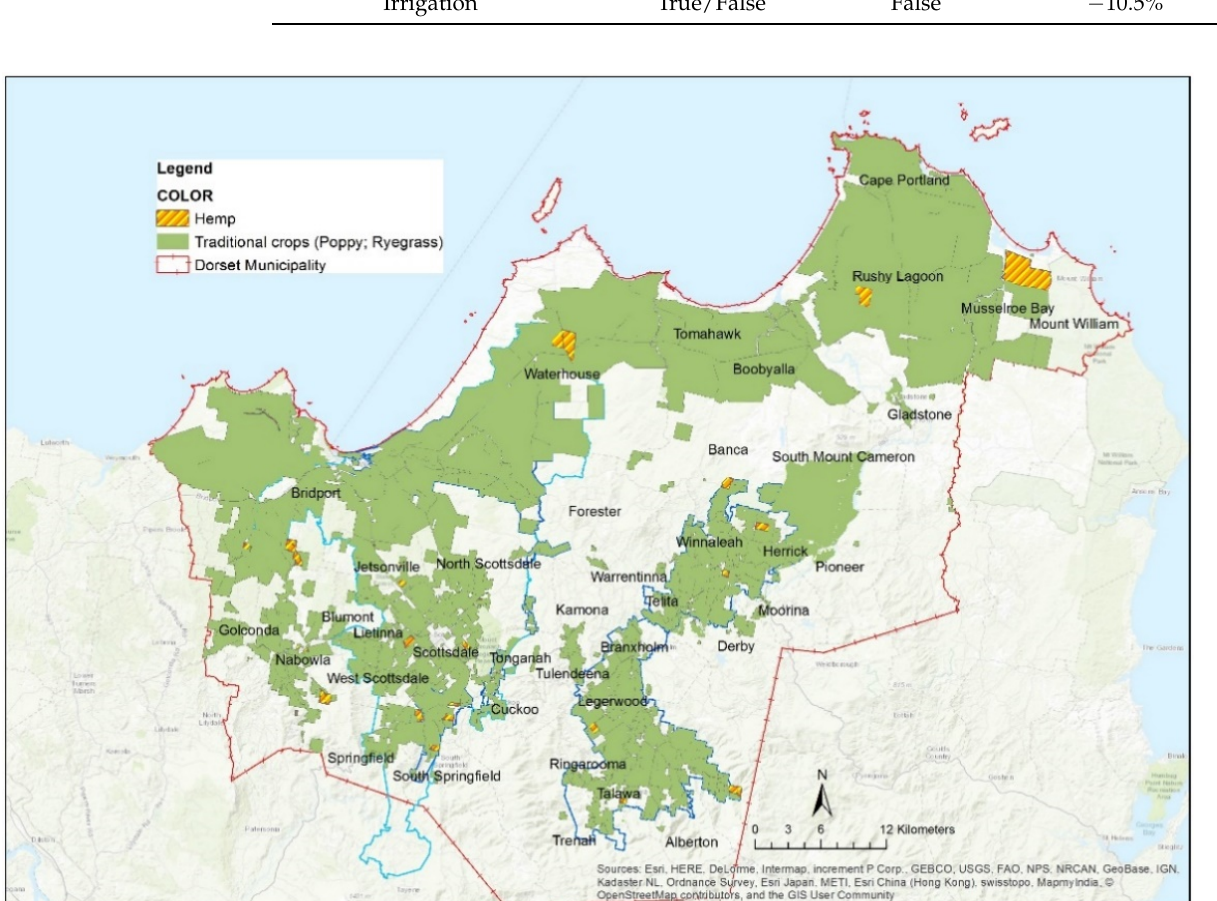
Figure 7. Distribution of hemp crops in Year 1 in the Dorset region for the default scenario as irrigation infrastructure became available.